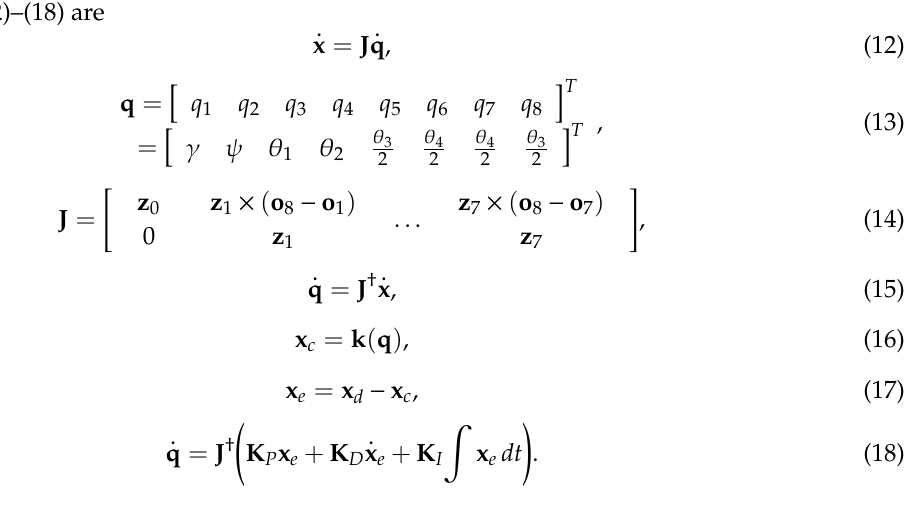
Figure 15. Block diagram of the open-loop control via the path generator to solve the differential inverse kinematics with the PID control algorithm.